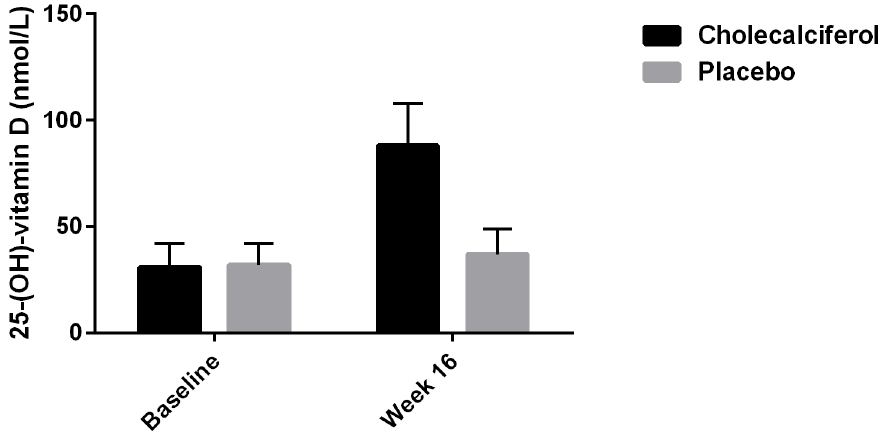
Fig 1. Treatment Effect on 25-OH Vitamin D Levels.